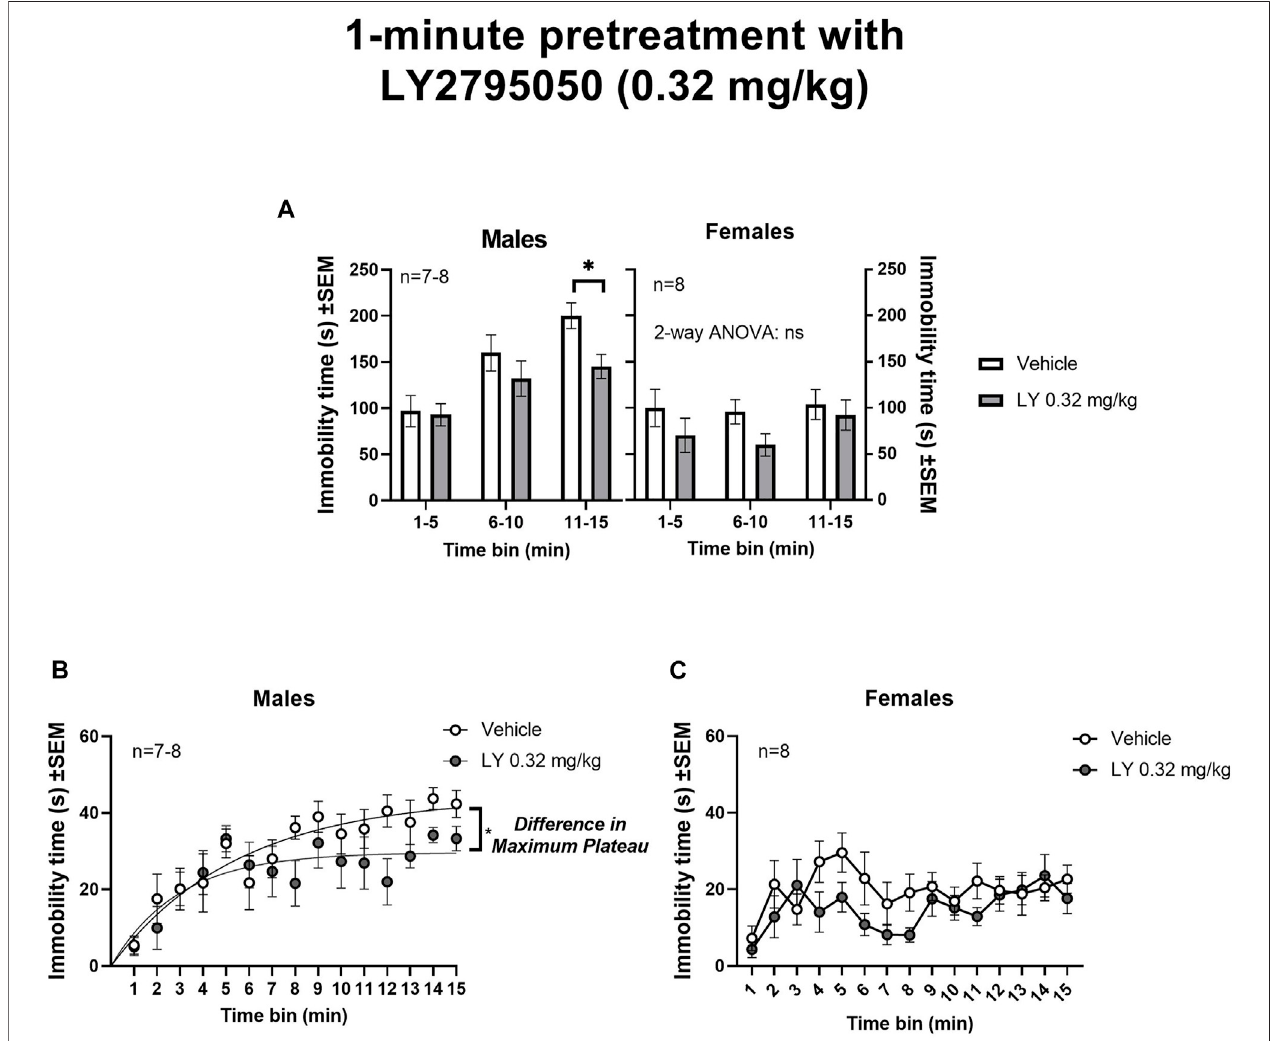
FIGURE 2 | Effect of 1-min pretreatment of LY2795050 (0.32 mg/kg, or vehicle) on immobility in the open space swim (15-min duration). (A) shows data in three consecutive 5-min bins, analyzed by mixed model 2-way ANOVA, in males and females (the data were also analyzed in a 3-Way ANOVA; see Results). (B,C) show data re-plotted as 1-min bins, in males and females respectively. The regression lines in (B) (males) shows exponential plateau growth curves (see Methods). The fi tted maximum plateau for immobility in males was signi fi cantly lower for LY2795050 versus vehicle (based on non-overlapping 95%CI). This regression could not be fi t for panel C